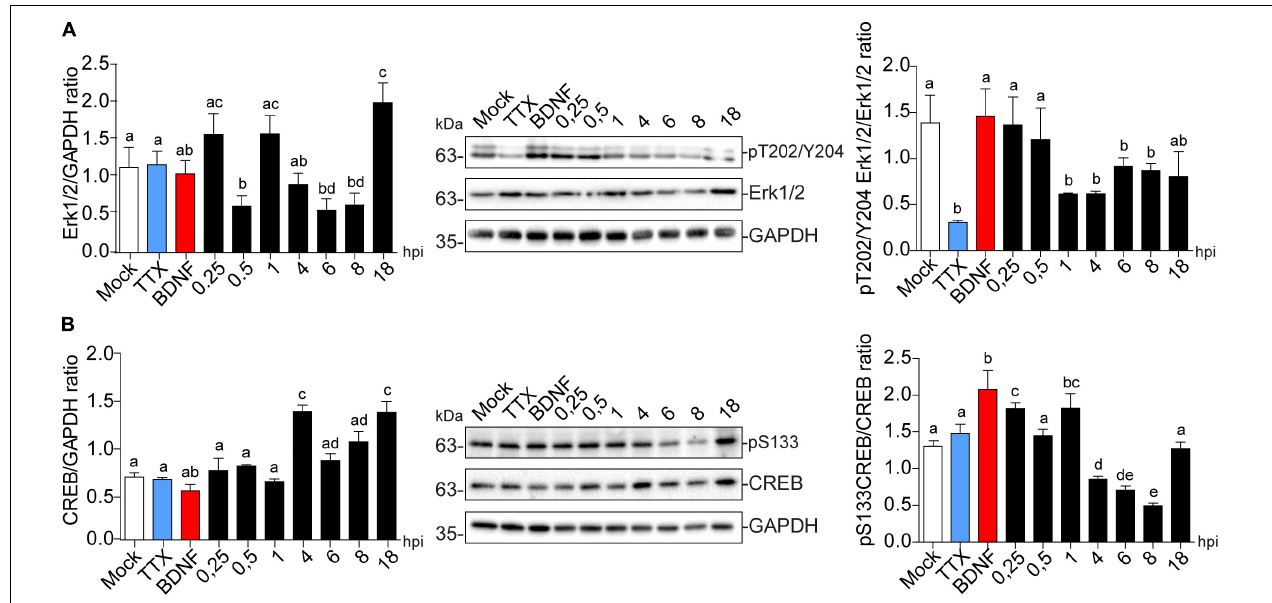
FIGURE 7 | HSV-1 induces CREB phosphorylation in the early stages of neuronal infection. Immunoblot analyses showing (A) Erk1/2 total protein expression (left panel) and phosphorylated levels in T202/Y204 (right panel) and (B) CREB total protein expression (left panel) and phosphorylated levels in S133 during HSV-1 infection kinetics (Mock, 0.25; 0.5; 1, 4, 6, 8, and 18 hpi), BDNF and TTX were used as positive and negative controls for signaling pathway activation and inhibition, respectively. Statistical significance was determined by One-Way ANOVA, followed by Tukey’s test. Bars represent the mean ± SD of biological replicates. Different letters above the mean bars apply to significant differences between groups p < 0.05. The blots are representative of three independent